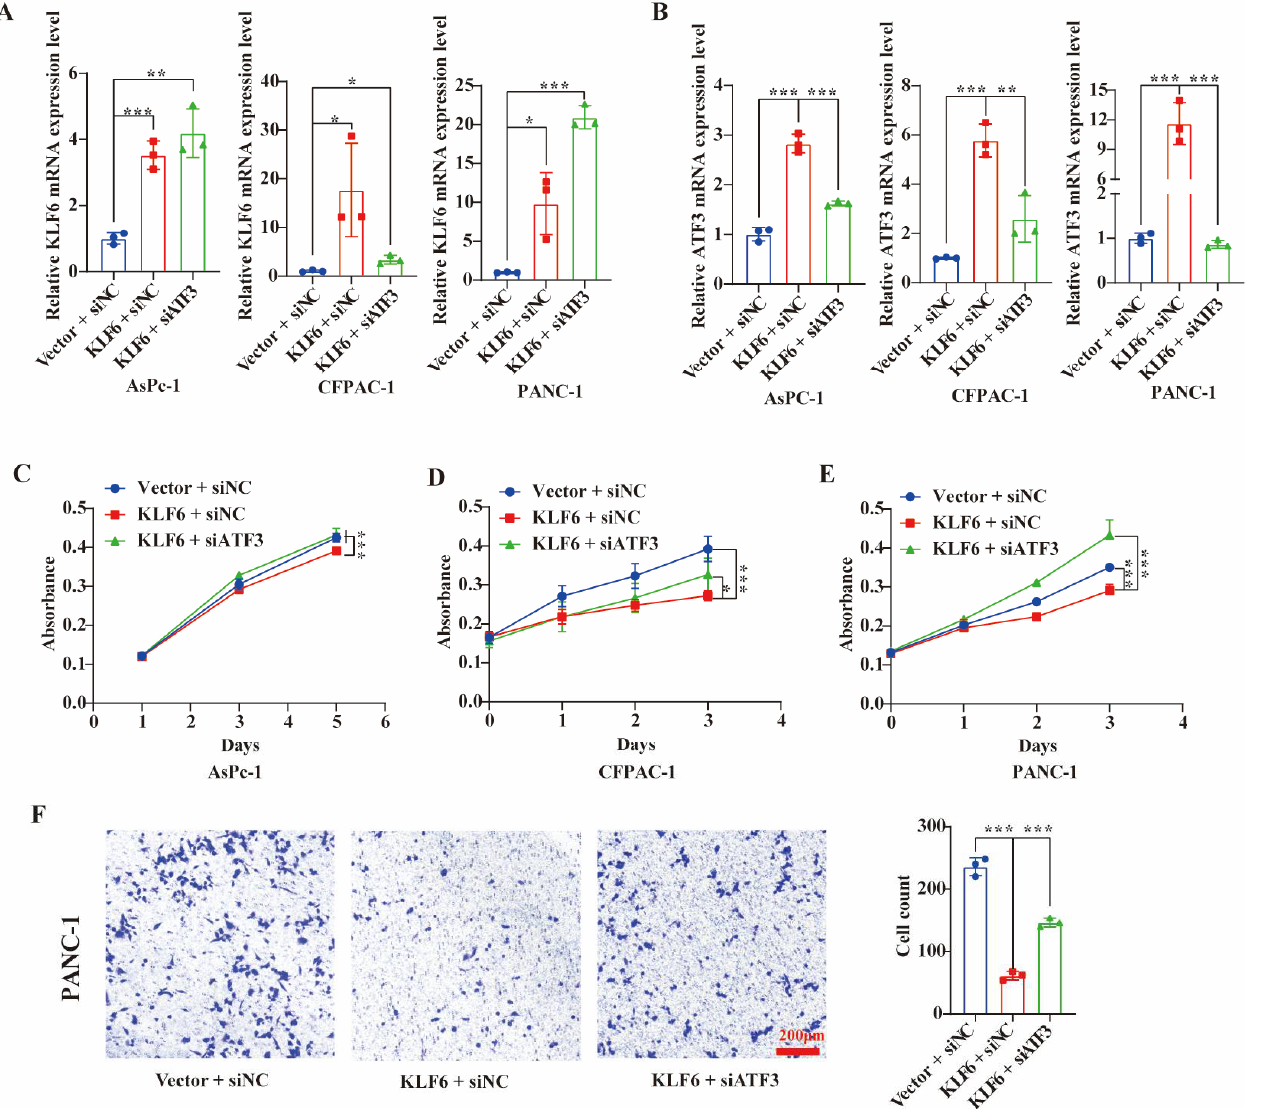
Figure 5. KLF6 inhibits the progression of pancreatic cancer through upregulating ATF3. ( A ) The relative mRNA expression levels of KLF6 after KLF6 overexpression or knockdown ATF3 in pancreatic cancer cells. Data represent mean ± SD; n = 3. * p < 0.05, ** p < 0.01, *** p < 0.001. ( B ) The relative mRNA expression levels of ATF3 after KLF6 overexpression or knockdown ATF3 in pancreatic cancer cells. Data represent mean ± SD; n = 3. ** p < 0.01, *** p < 0.001. ( C – E ) CCK8 assays were performed to measure the proliferation capacity after KLF6 overexpression or knockdown ATF3 in AsPC-1, CFPAC-1, and PANC-1. Data represent mean ± SD; n = 6. * p < 0.05, ** p < 0.01, *** p < 0.001. ( F ) The migration capacity was measured after KLF6 overexpression or knockdown ATF3 in AsPC-1, CFPAC-1, and PANC-1. Data represent mean ± SD; n = 3. *** p < 0.001.